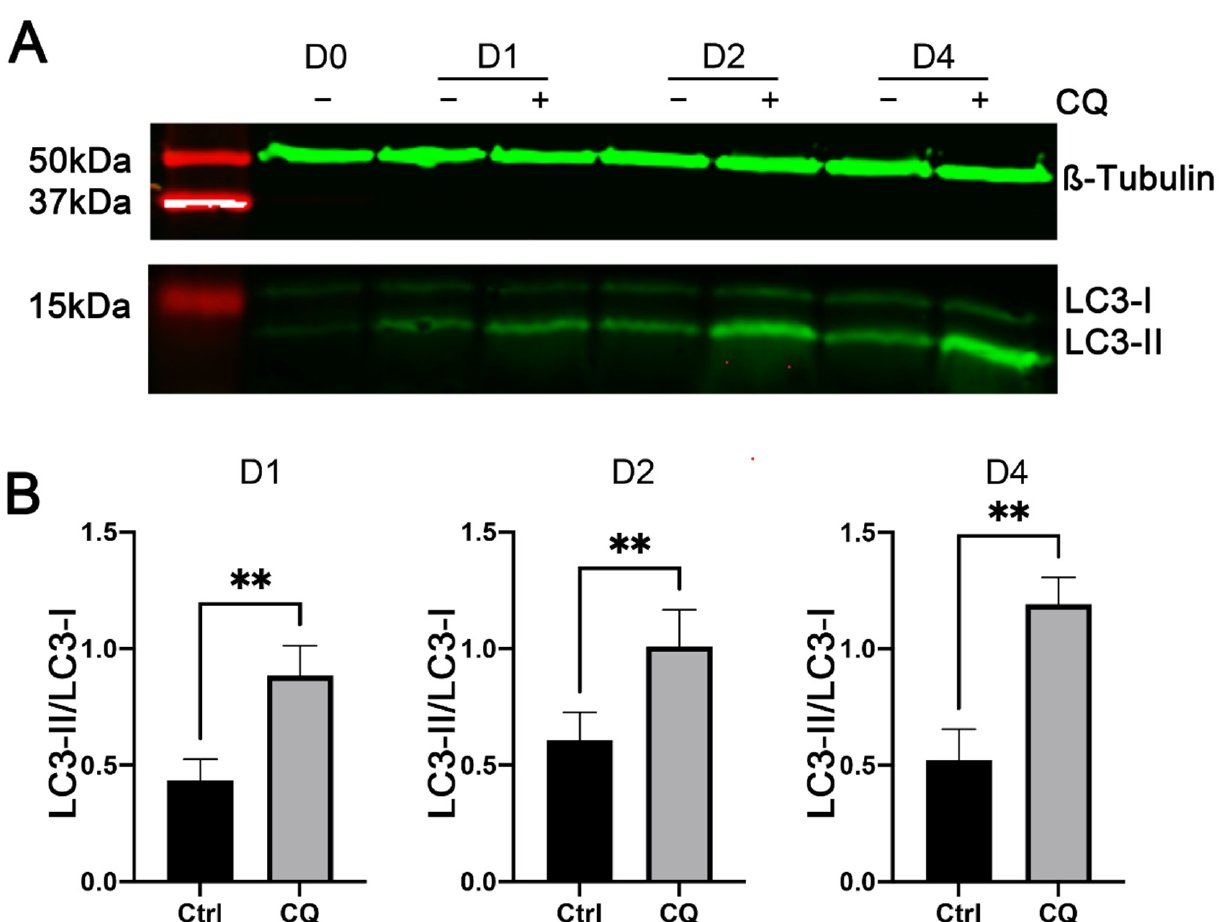
Figure 4. Effects of chloroquine (CQ) on LC3-I and LC3-II protein expression in C2C12 cells during myogenic differentiation. C2C12 cells were cultured in differentiation medium in the presence (+) or absence ( − ) of 20 µ M CQ. Total protein lysates from cells on days 0 (D0, before differentiation), 1 (D1), 2 (D2), and 4 (D4) of differentiation were analyzed by Western blotting, using antibodies specific to LC3 and β -Tubulin (as a loading control). ( A ) Representative images of Western blots. ( B ) Ratio of LC3-II to LC3-I protein. ** indicates p < 0.002 ( n = 5), based on t -tests.